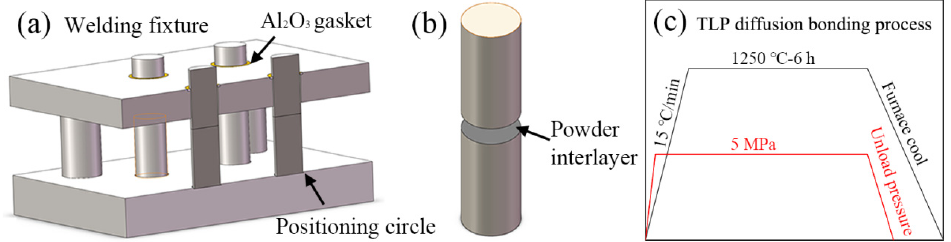
Figure 2. Specimen assembly diagrams and TLP diffusion bonding process: ( a ) welding fixture; ( b ) powder interlayer assembly diagram; ( c ) TLP diffusion bonding process.